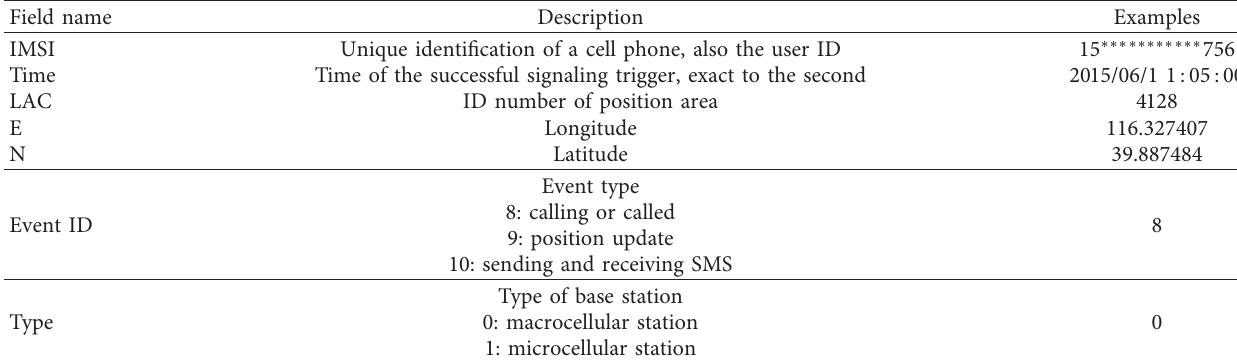
Table 1: CDR data format and